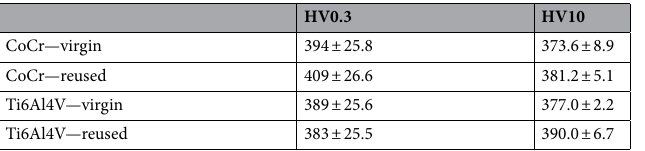
Table 5. Measurements of Vickers hardness, HV 0.3 and HV 10, for CoCr and Ti6Al4V samples printed with new and recycled powder, determined on polished surfaces by optical microscope.